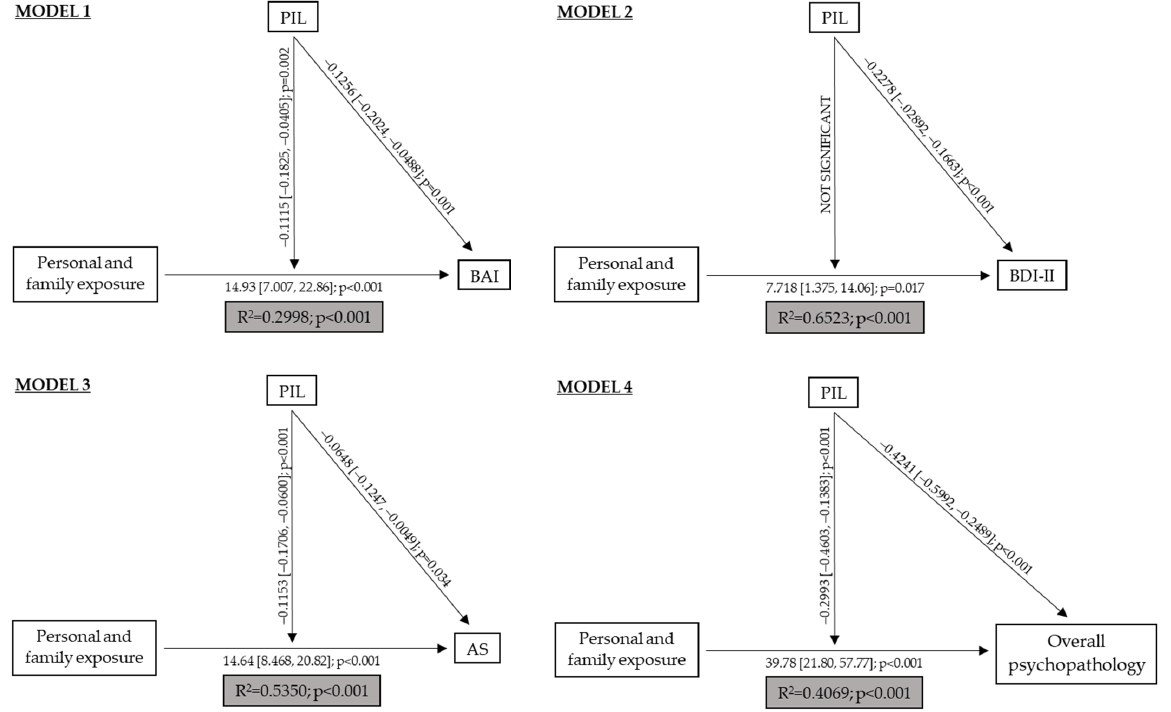
Figure 1. Explanatory models of psychopathology in healthcare workers. PIL: Purpose in Life; BAI: Beck’s Anxiety Inventory; BDI-II: Beck’s Depression Inventory; AS: Acute Stress.